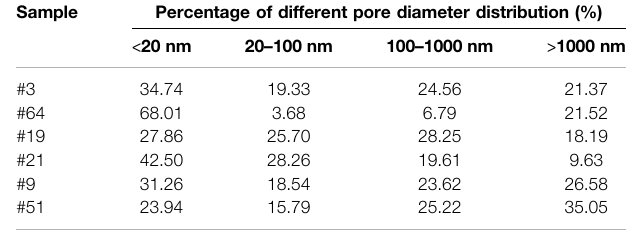
TABLE 3 | Statistics on the percentage of different pore diameter distribution before cracking. Sample